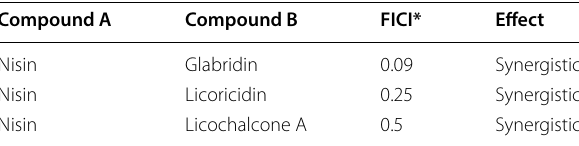
Table 3 Fractional inhibitory concentration index (FICI) values for combinations of nisin and licorice polyphenols against E. faecalis ATCC 19433